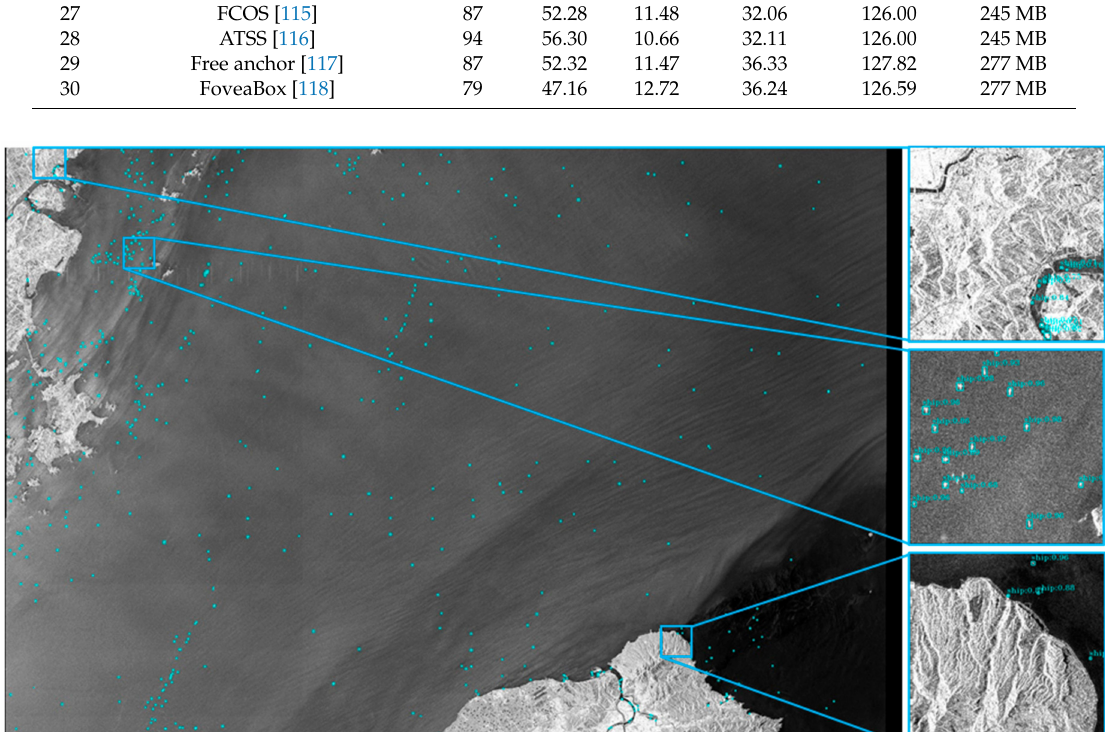
Figure 16. SAR ship detection results taking Faster R-CNN as an example on the